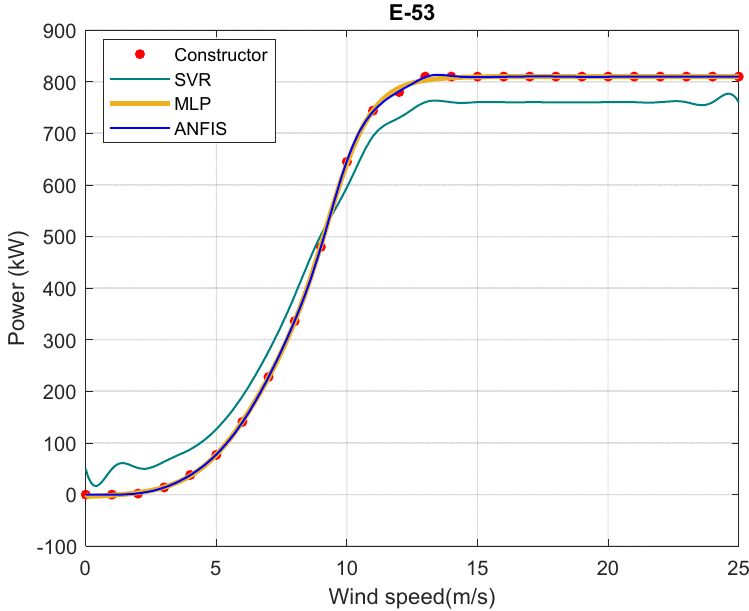
Figure 6. Characteristic power curve modeling for E-48.